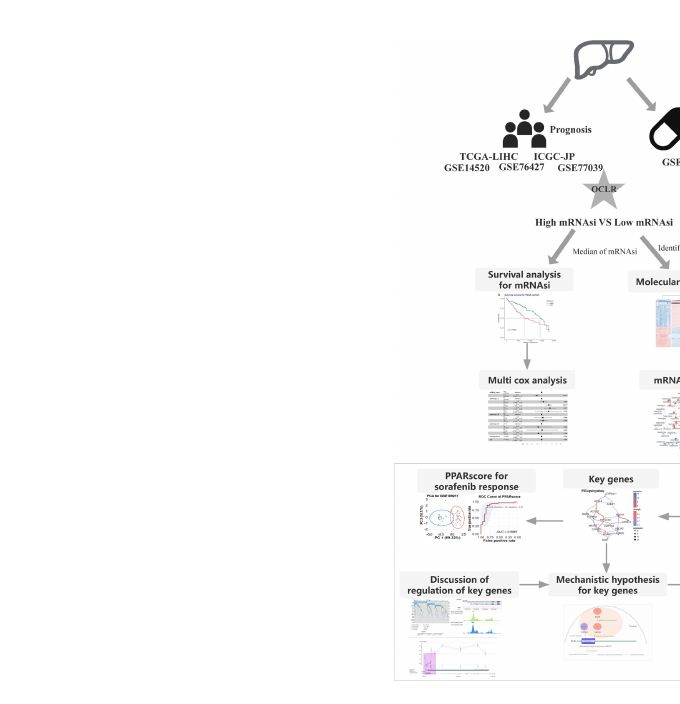
FIGURE 1 | The fl owchart demonstrates the analytical process of calculating HCC stemness and its association with the response to sorafenib treatment and HCC patient